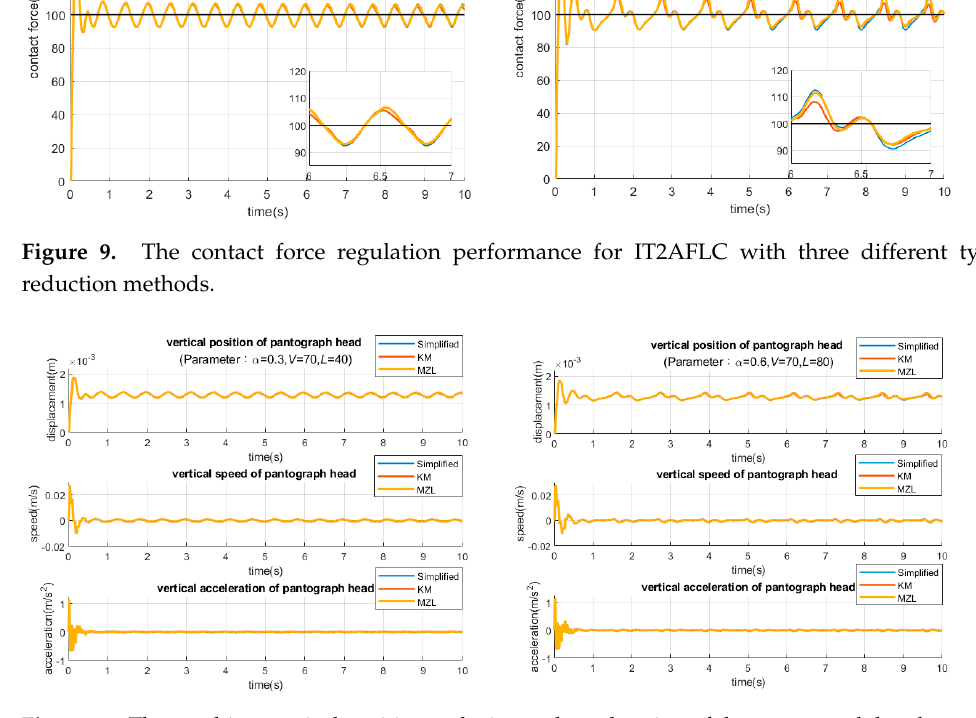
Figure 10. The resulting vertical position, velocity, and acceleration of the pantograph head.